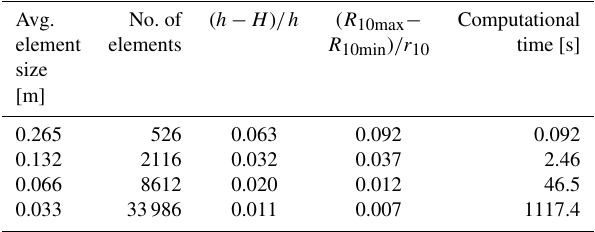
Table 1. Influence of mesh size on model accuracy and computa- tional